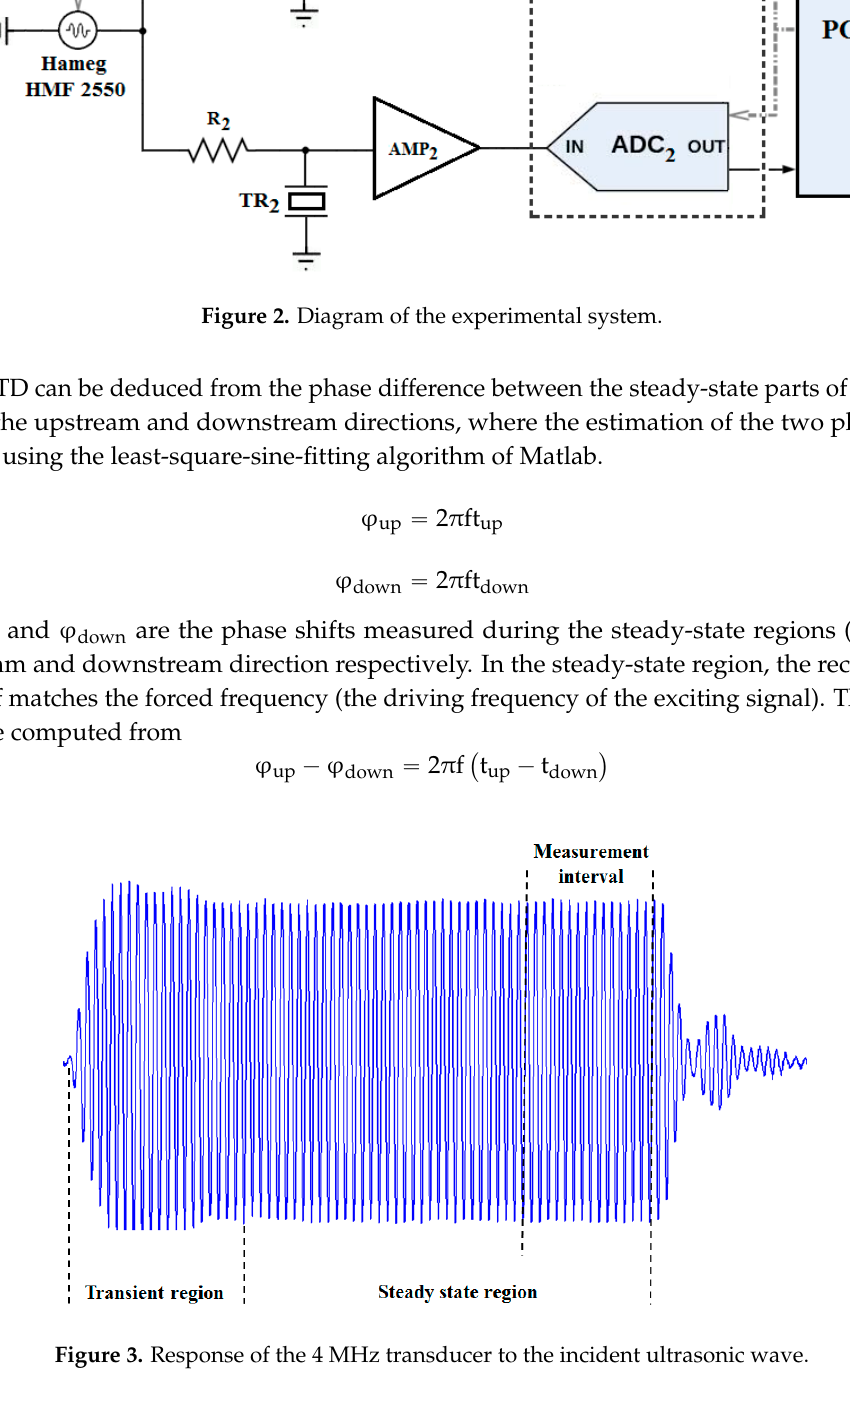
Figure 3. Response of the 4 MHz transducer to the incident ultrasonic wave.